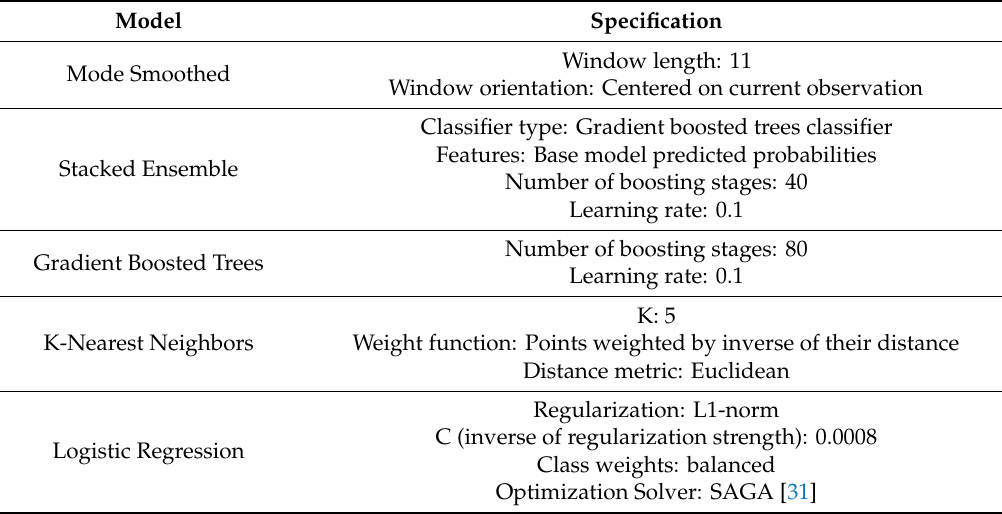
Table A1. Final hyperparameter specifications for the models used in this